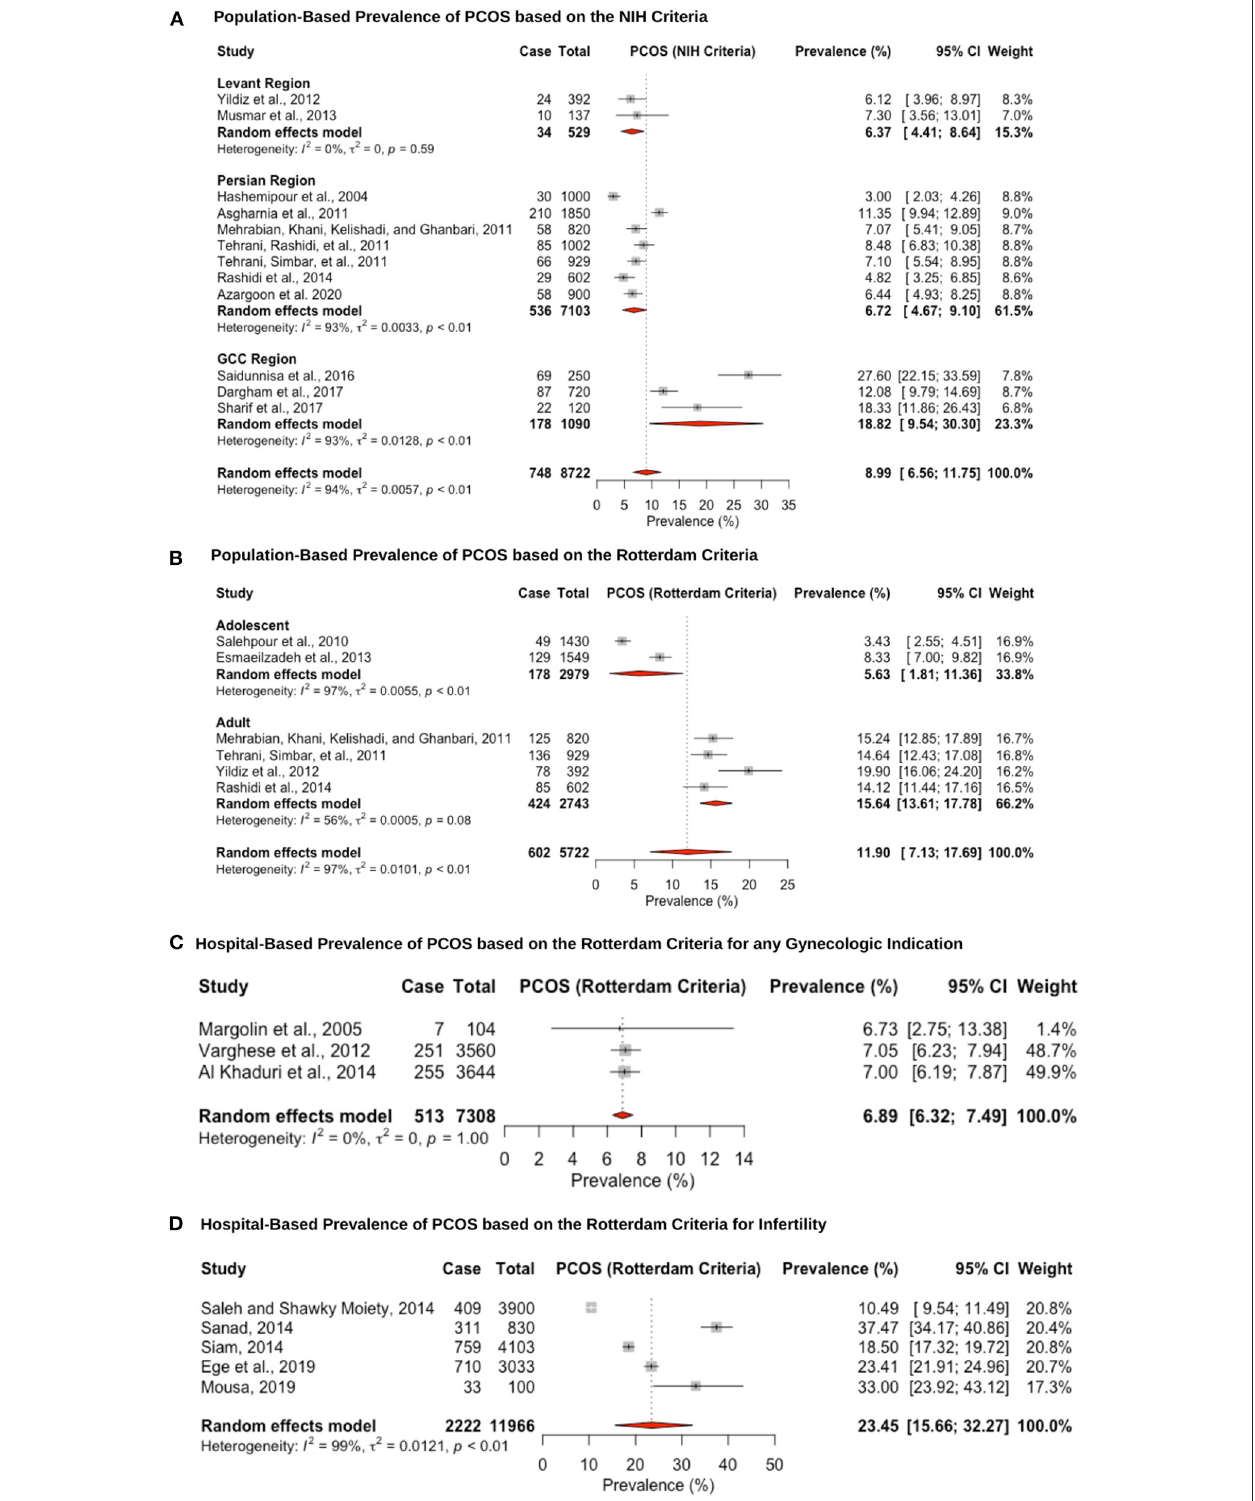
FIGURE 2 | Forest plot of the pooled prevalence estimates of PCOS: (A) population-based study based on the NIH criteria, (B) population-based study based on the Rotterdam criteria, (C) hospital-based study (obstetrics and gynecology department) based on the Rotterdam criteria, and (D) hospital-based study (presenting with infertility) based on the Rotterdam